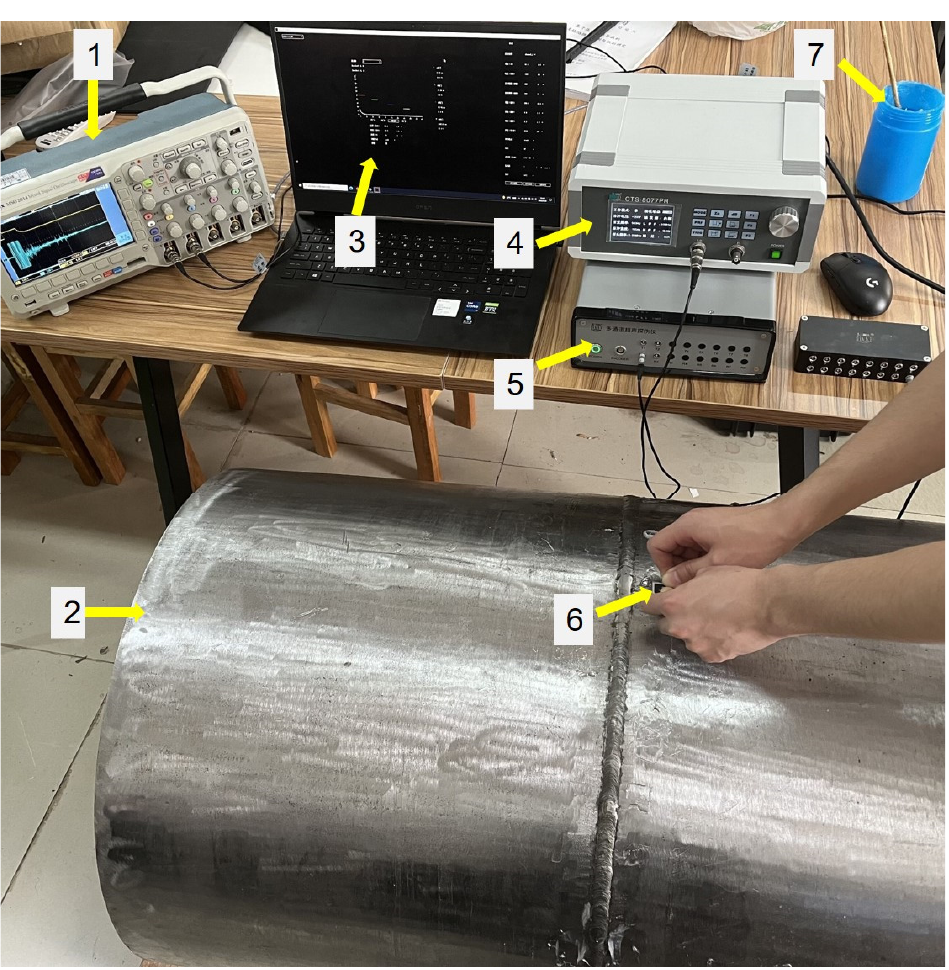
Figure 8. Experimental platform: 1—oscilloscope, 2—butt-welded pipeline test sample, 3—ultrasonic signal acquisition system interface, 4—ultrasonic pulser/receiver, 5—two-channel ultrasonic system, 6—PMUT linear array probe, 7—ultrasonic couplant.